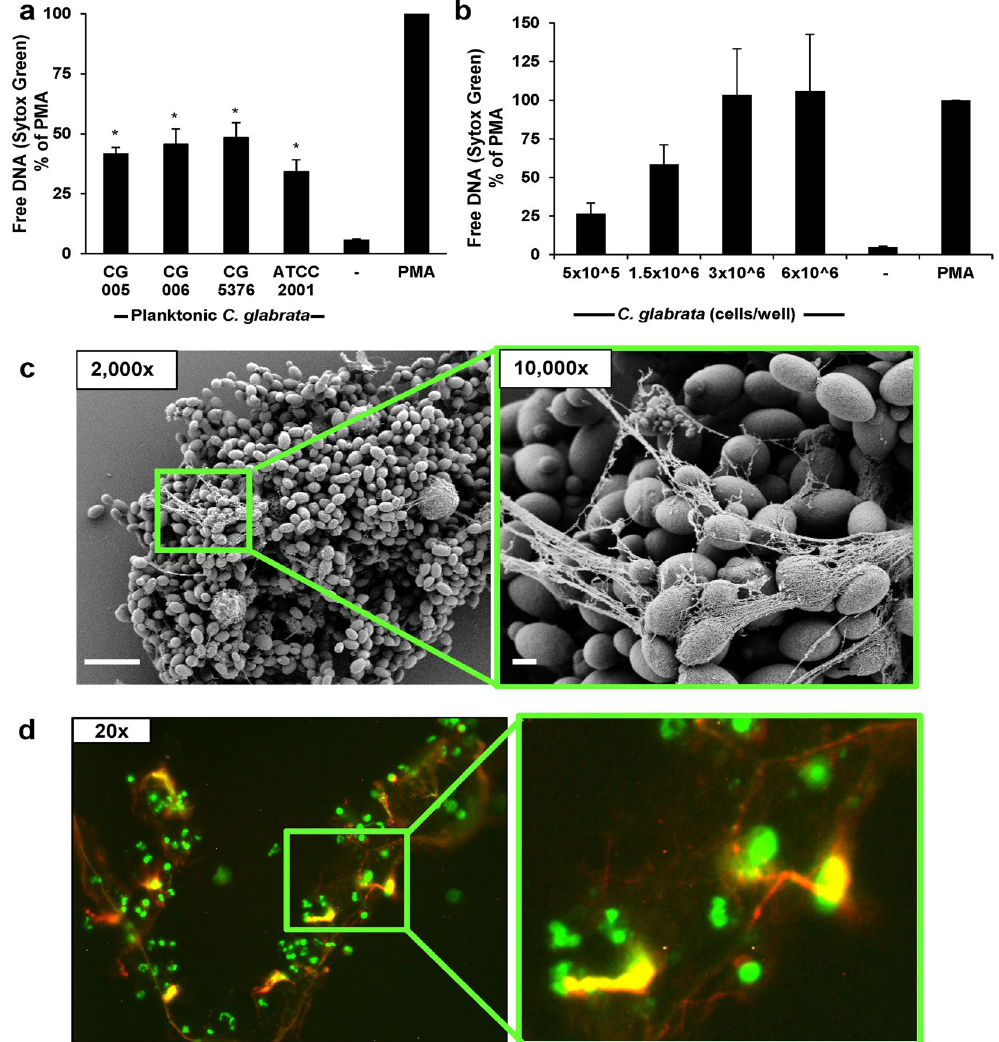
Figure 1. Planktonic C . glabrata induce release of NETs. ( a ) Human neutrophils were exposed to four strains of planktonic C . glabrata (1.5 × 10 6 cells/well) for 4 h. NET release was estimated by Sytox Green detection of free DNA. Results were normalized for the positive control, PMA, and data from 5 experiments performed in triplicate were combined. Neutrophil responses to Candida were analyzed by ANOVA with pairwise comparison to the untreated neutrophil control, * P < 0 . 05 , SEM shown . ( b ) Various concentrations of planktonic C . glabrata (CG 006) were co-cultured with human neutrophils for 4 h and NET release was estimated using Sytox Green. Results were normalized for the positive control, PMA, and data from 5 experiments performed in triplicate were combined, SEM shown . ( c ) Neutrophil interactions with planktonic C . glabrata at 4 h were imaged with scanning electron microscopy. Measurement bars represent 10 µ m and 1 µ m for 2,000x and 10,000x images, respectively. ( d ) Following co-culture with C . glabrata for 4 h, the neutrophil response was visualized by immunofluorescence using an anti-citrullinated H4 antibody (red) and Sytox Green staining of DNA